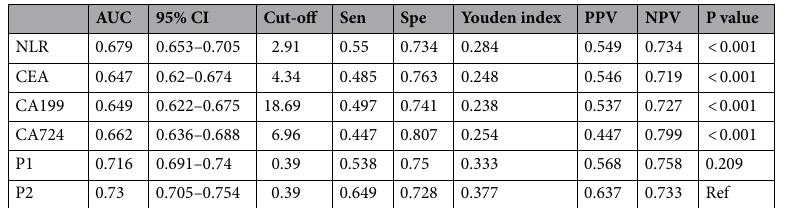
Table 2. AUC and the cutoff value of diagnostic indicators at the maximum of Youden index for GC metastases (N = 1667). AUC area under receiver operating characteristics, CI confidence interval, Sen sensitivity, Spe specificity, PPV positive predictive value, NPV negative predictive value, P P value for comparison of AUC of reference with other indicators using DeLong’s test, P1 prediction probability obtained by binary logistic regression combining CEA, CA199, CA724, P2 prediction probability obtained by binary logistic regression combining CEA, CA199, CA724 and NLR, Ref reference.